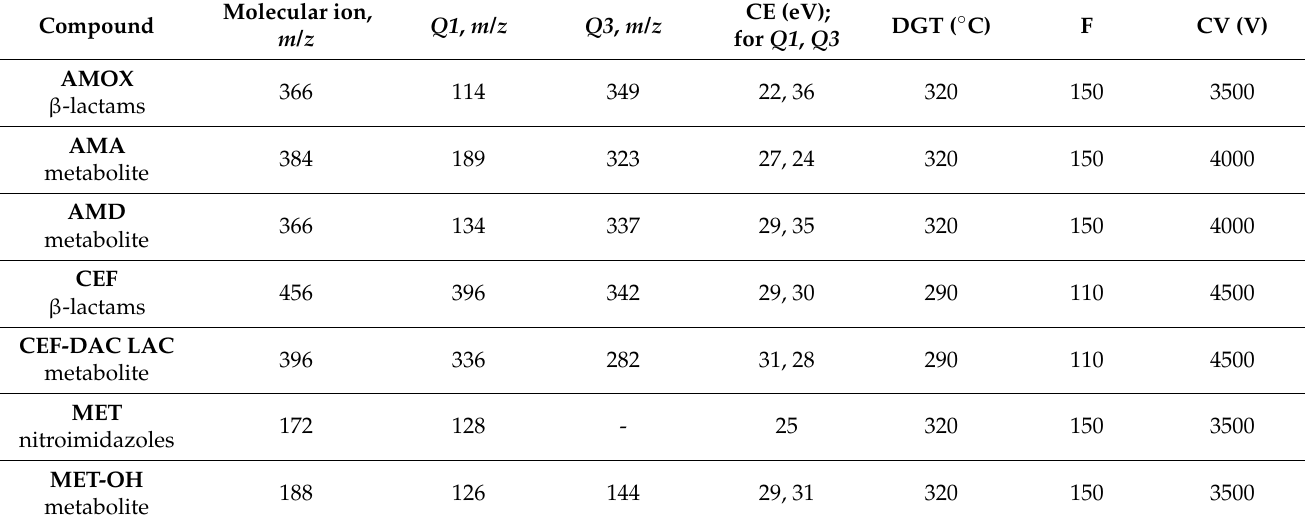
Table 2. Mass spectrometry parameters applied for the determination and identification of relevant antibiotics and their metabolites in human